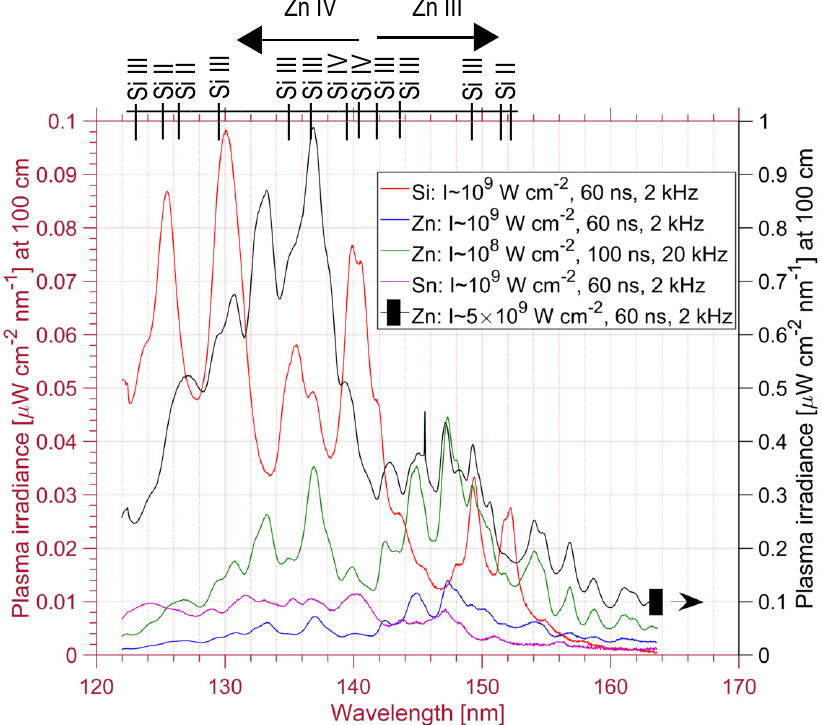
Figure 3. Measured FUV spectral irradiances of the Si, Zn and Sn plasmas at a distance of 100 cm from the target over the ≈ 123–164 nm wavelength region. Plasmas were generated by a 1.0 µ m laser at two operation regimes: with pulse widths of 60 and 100 ns FWHM and the repetition rates of 2 and 20 kHz. Note that the right ordinate is used for one of the Zn spectra (marked with a filled rectangle) for better view. Here, the laser irradiances (pulse energies) for 2 and 20 kHz rep-rates are ≈ 10 9 W cm − 2 ( ≈ 3 mJ), ≈ 5 × 10 9 W cm − 2 ( ≈ 15 mJ), and ≈ 10 8 W cm − 2 (20 kHz, 100 ns FWHM laser pulse energy ≈ 0.6 mJ), respectively. Positions of Si spectral lines are shown (on top) using the NIST atomic database